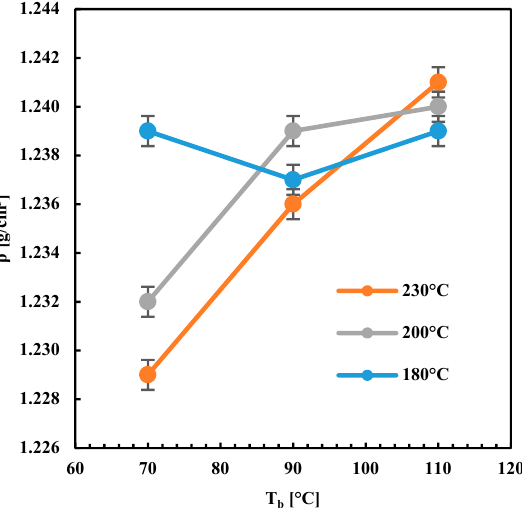
Figure 6. Optical micrographs of the specimens obtained at different T n and T b . The part of the specimen farer from the deposition plate has been shown. T n and T b have been also indicated in the figure (see Table 1 for operative conditions).